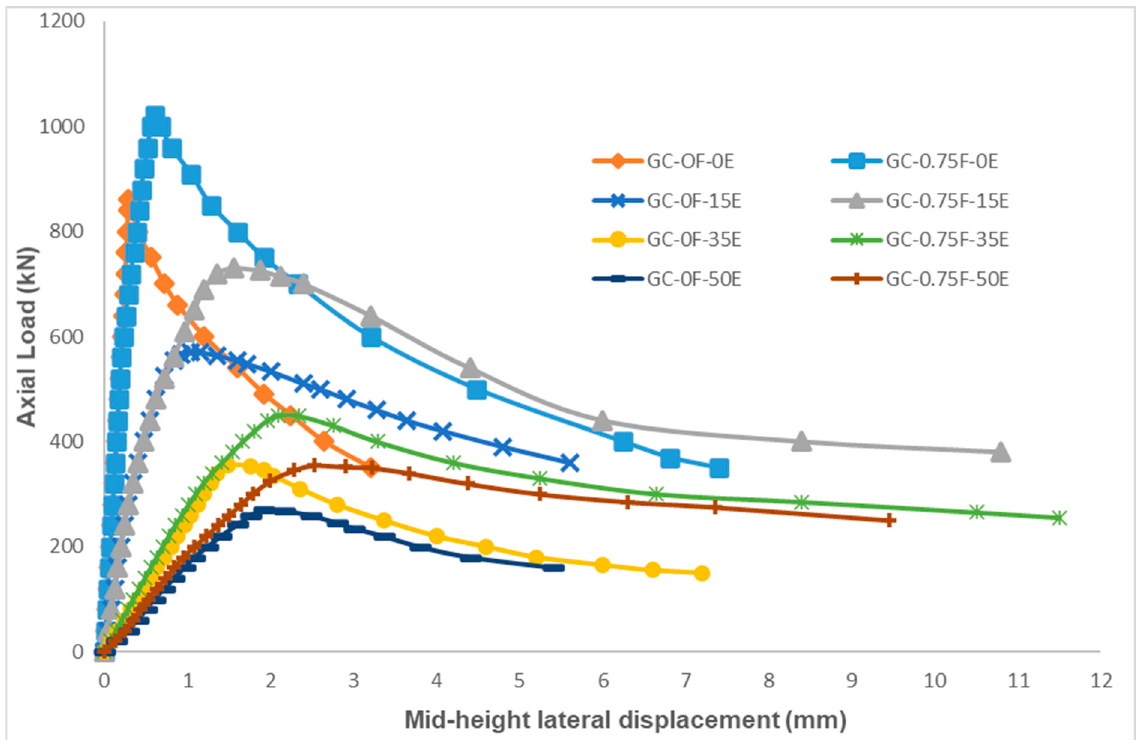
Figure 13. The axial load–lateral displacement behavior of GC columns.